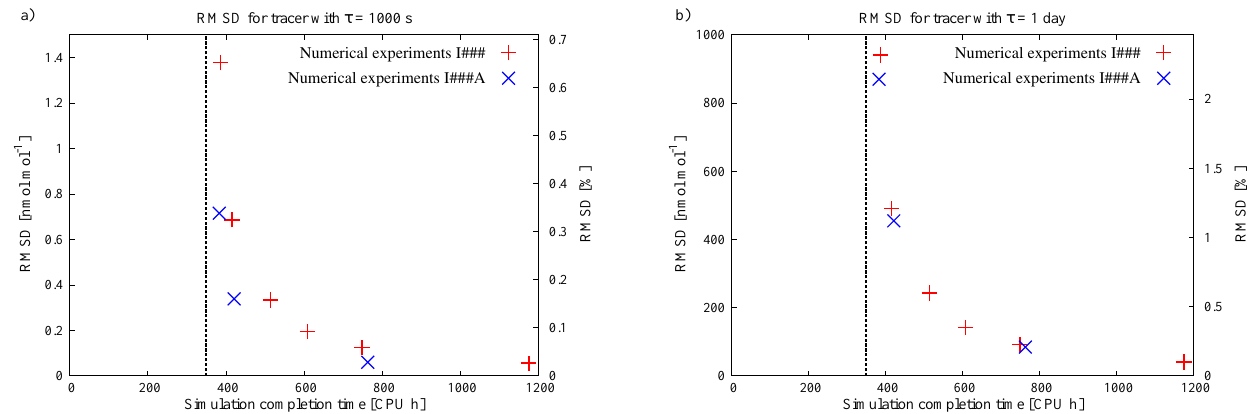
Figure 4. Root mean square deviations of the 2001 averaged mixing ratios compared to reference case I001 for decaying scalars with a lifetime of (a) 1000s and (b) 1 day. On the vertical axes, the RMSD is expressed in both absolute numbers and as percentages of the air- mass-weighted mixing ratios. On the horizontal axis, the computational time used by the numerical experiments is depicted. The red pluses, from left to right, represent the numerical experiments I100, I050, I025, I015, I010 and I005. The blue crosses represent the numerical experiments I100A, I050A and I010A. The dotted line expresses the computational time used by